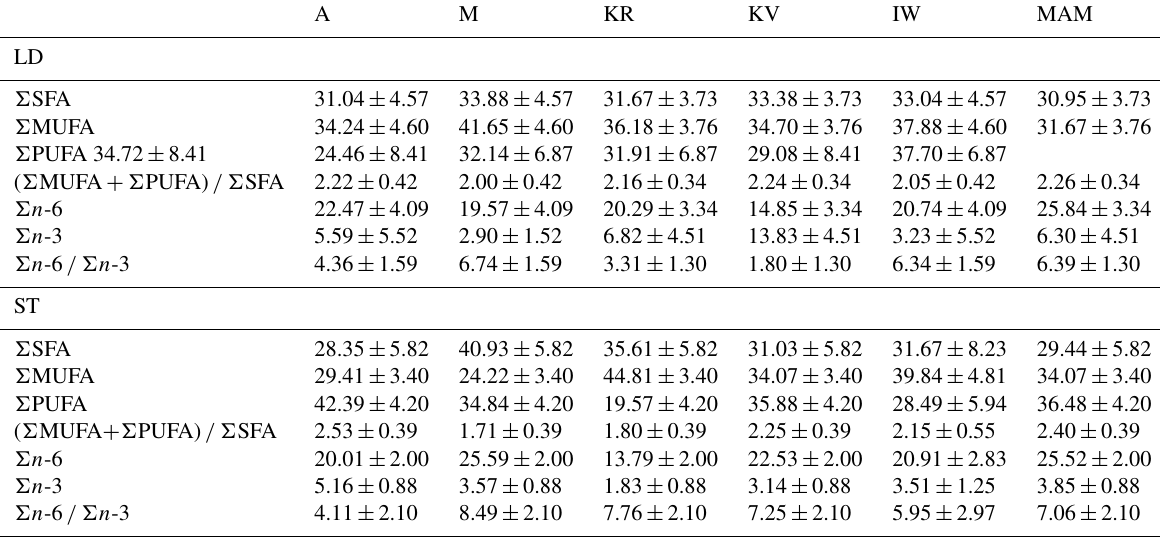
Table 4. Fatty acid composition of longissimus dorsi and semitendinosus muscles from male lambs born to Turkish indigenous sheep breeds. A M KR